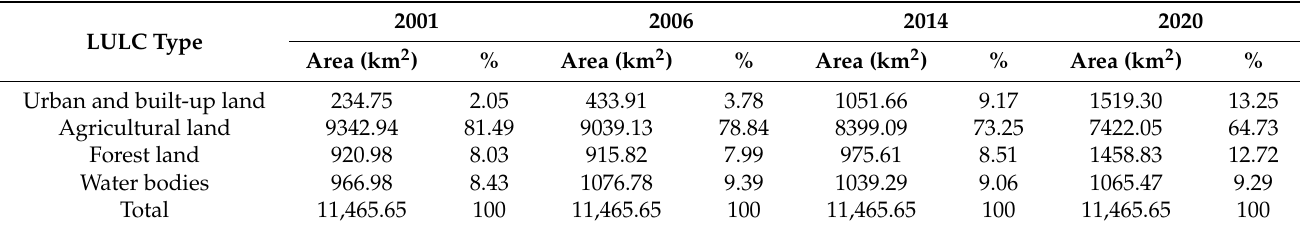
Table 3. Areas and percentages of classified LULC map in 2001, 2006, 2014, and